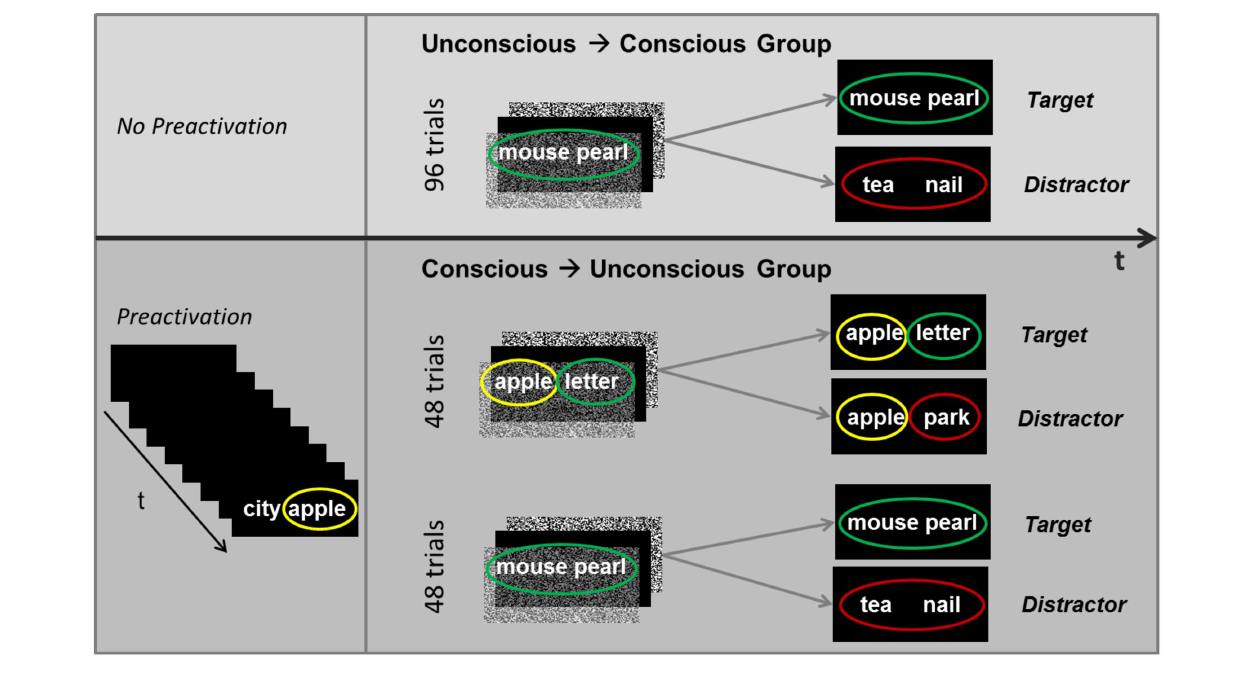
word pair on a trial-by-trial basis.The test of awareness was different for the two experimental groups because subliminal words (B words in B–C pairs) were primed by previously perceived supraliminal words (A–B pairs) in the conscious → unconscious group (bottom panel) but not the unconscious → conscious group (top panel). t ,